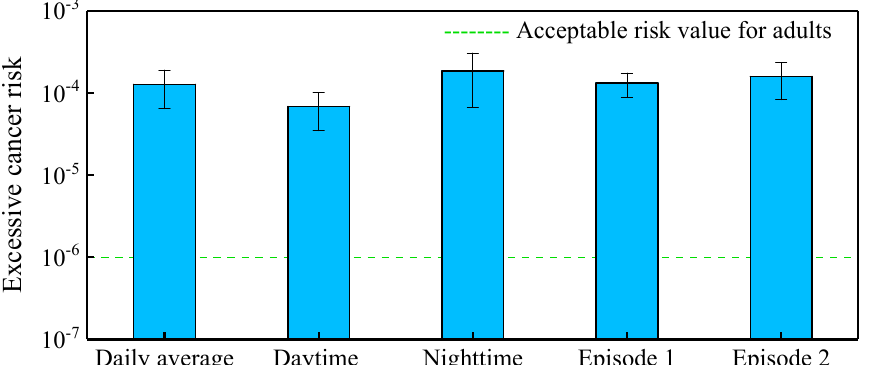
Figure 10. Comparison of excessive cancer risk of PAHs in the study area during the monitoring period.